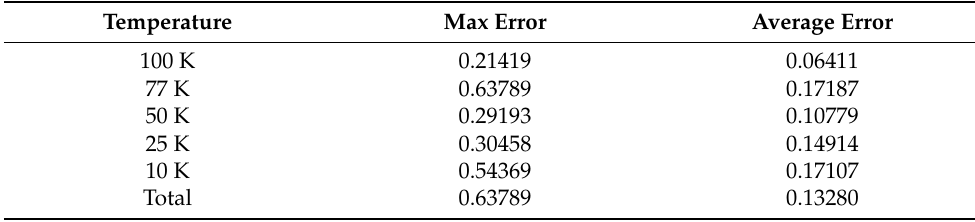
𝑋 𝑇 is is t ox 𝑡 𝑜𝑥 τ e